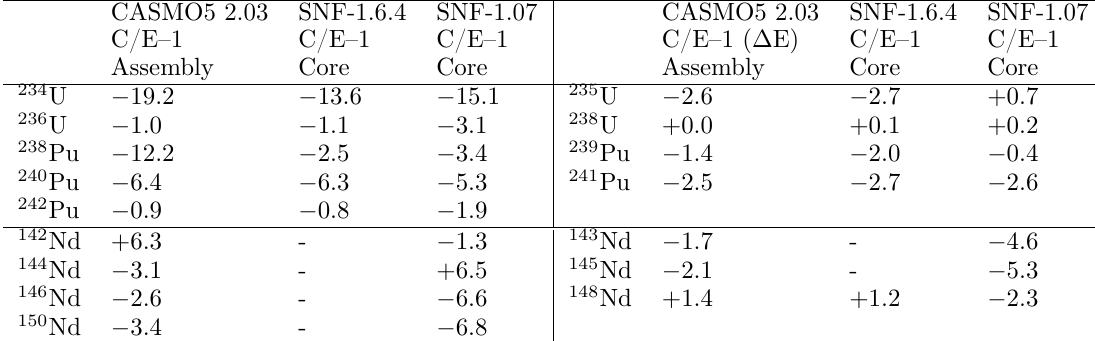
Table B.5. Nominal C/E–1 values in % for the BM3 sample. No experimental uncertainties are reported in the ARIANE report [3].